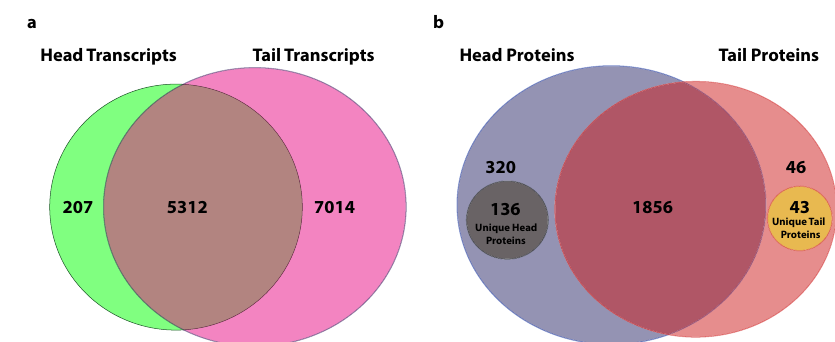
Fig. 1 Total identi fi ed proteins and transcripts in cercarial heads and tails. a Venn Diagram showing all transcripts identi fi ed above the ≥ 1.0 normalized count threshold in one or both macrostructures. b Venn Diagram showing proteomic identi fi cation of proteins with ≥ 2 unique peptides, identi fi ed in ≥ 2 replicates. b includes sub-populations of unique head and unique tail proteins identi fi ed in ≥ 2 replicates in one macrostructure and 0 replicates in the other macrostructure. One hundred and thirty-six (136) unique head proteins were identi fi ed only in cercarial heads, and 43 unique tail proteins were identi fi ed only in cercarial tails. All supporting data is contained in Supplementary Data 1. Replication n = 3 independent biological replicates.